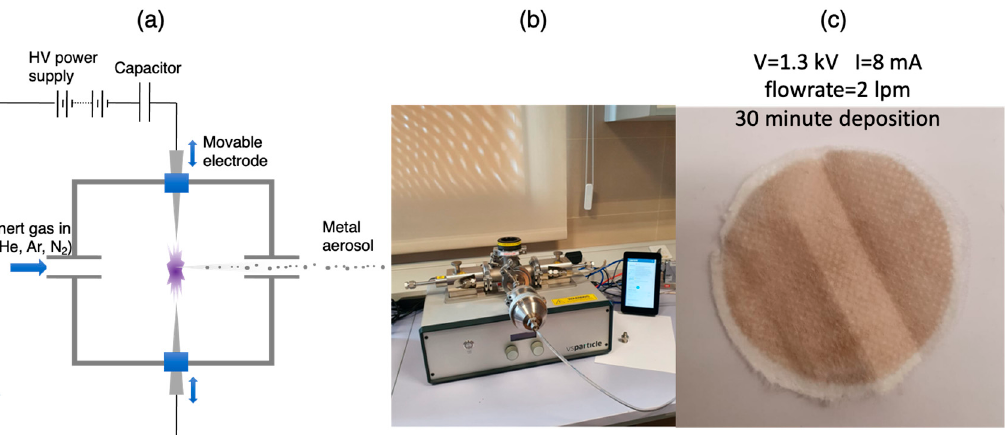
Figure 2. Nanoparticle synthesis and textile coating. ( a ) Production of nanoparticle aerosol using a spark source. ( b ) the device used, which was the VSP-G1 source produced by VSParticle B.V. The cloth to be coated is trapped in a commercially available chamber and acts as a filter for the nanoparticles. ( c ) A typical coating on a piece of facemask material after 30 min with the source parameters shown. ( a ) Reproduced with permission from [41]. Copyright 2021, John Wiley and